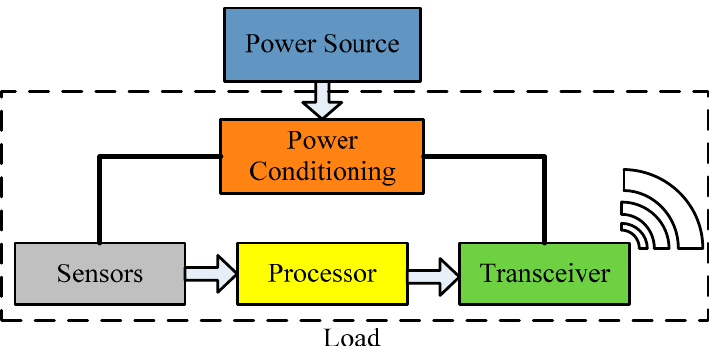
Figure 8. Block diagram of the autonomous sensors [51].